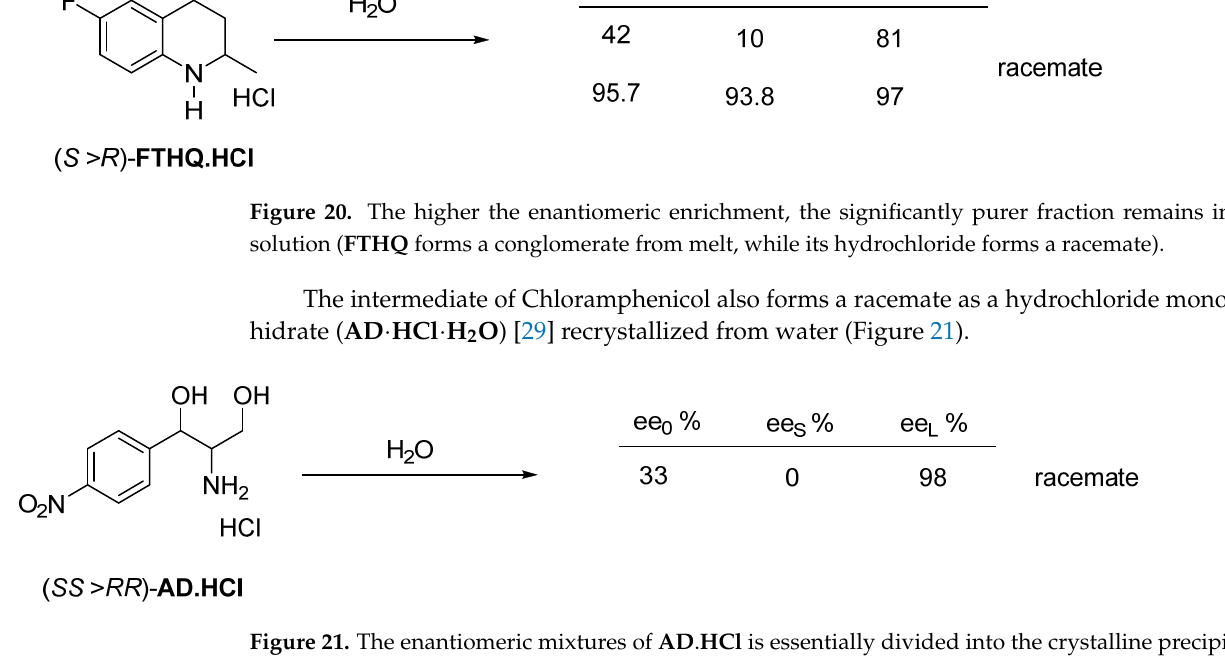
Figure 21. The enantiomeric mixtures of AD . HCl is essentially divided into the crystalline precipi- tated racemic fraction and the enantiomeric fraction leading to the pure final product by recrystalliza-